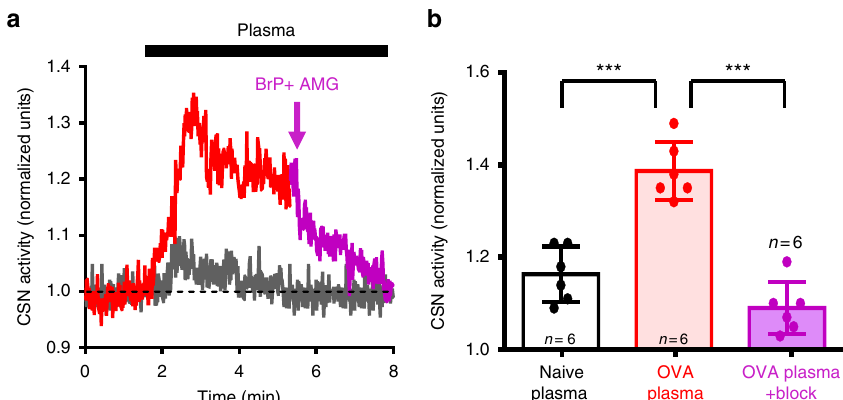
Fig. 5 Plasma from ovalbumin-sensitized rats increases carotid body activity in LPA receptor-dependent manner. a Carotid sinus nerve activity from a naive en bloc carotid body preparation in response to plasma from naive (gray trace) and OVA-sensitized (red trace) rats. Application of dual LPAr and TRPV1 blockade (AMG9810, 10 µ M + BrP-LPA, 1.5 µ M) is indicated by the mauve arrow and subsequent trace. b Summary data of the effect of naive (open) and OVA (red) plasma as well as subsequent dual blockade (mauve). F 2,17 (one-way ANOVA) = 40.193, *** p < 0.001, mean ± sem. Holm – Š idák post hoc: OVA vs naive p < 0.001; OVA vs blockade p <